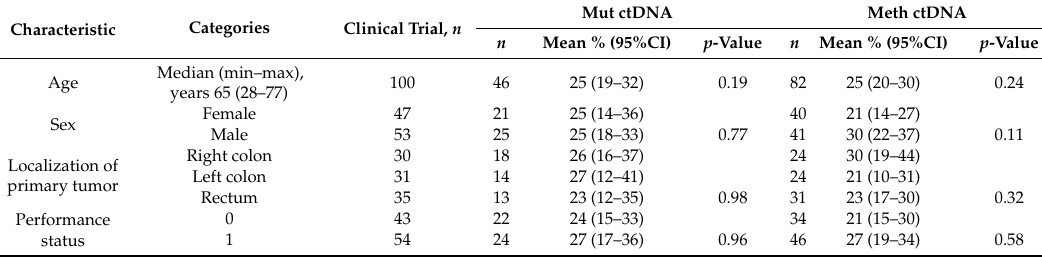
Table 4. Patient characteristics of the biomarker population. Correlation between patient characteristics and the mean level of circulating tumor DNA (ctDNA) at baseline determined either by RAS / RAF mutation (Mut ctDNA) or NPY methylation (Meth ctDNA) in the biomarker population, n = number, CI = confidence interval. In 82 patients a baseline plasma sample was available and the correlations are based on these patients.